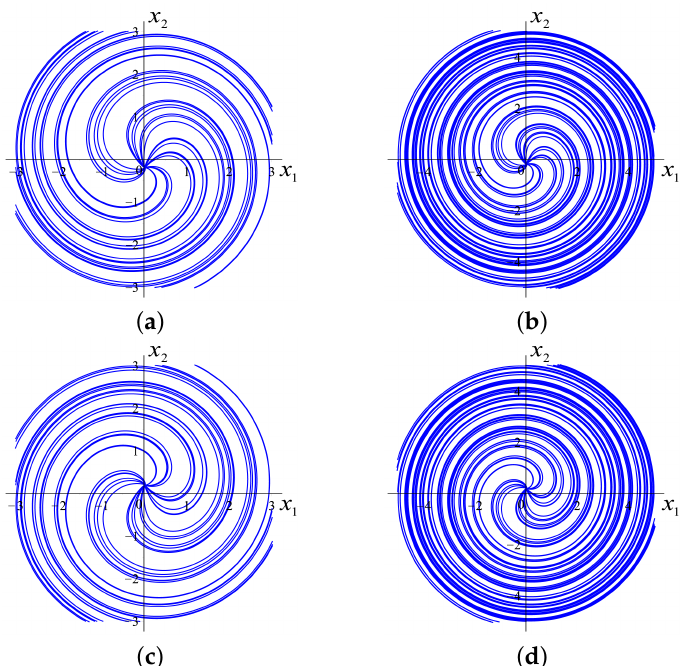
Figure 3. Phase portraits of ( x 1 , x 2 ) plane: ( a ) Stable region ( x i ∈ [ − 3,3 ] ); ( b ) Stable region x i ∈ [ − 5,5 ] ); ( c ) Unstable region ( x